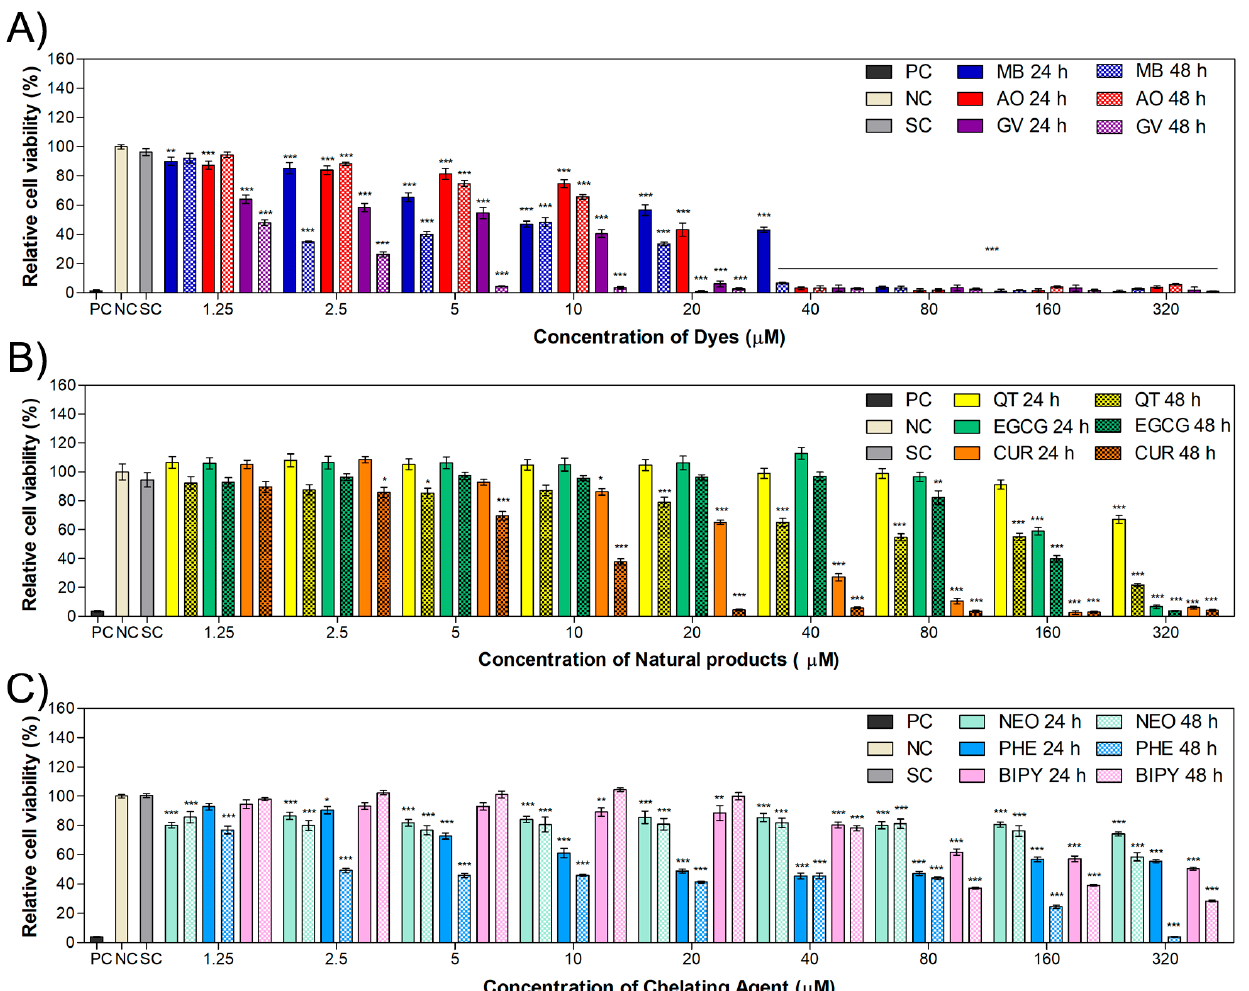
Figure 2. Relative cell viability of the MET1 cell line treated for 24 or 48 h with ( A ) dyes (MB, AO and GV), ( B ) natural compounds (QT, CUR and EGCG) or ( C ) chelating molecules (NEO, PHE and BIPY) with a range of concentration from 1.25 µM to 320 µM. Values are presented the mean ± combined standard uncertainty ( n = 4), and statistical significances comparing the results to the cell viability of the negative control were determined by a two-way ANOVA with Bonferroni post test, where * p < 0.05, ** p < 0.01 and *** p < 0.001. MB: methylene blue, AO: acridine orange, GV: gentian violet, QT: quercetin, EGCG: epigallocatechin gallate, CUR: curcumin, NEO: neocuproine, PHE: 1,10-phenanthroline, BIPY: 2,2 ′ -bipyridyl, PC: positive control, NC: negative control, SC: solvent control.